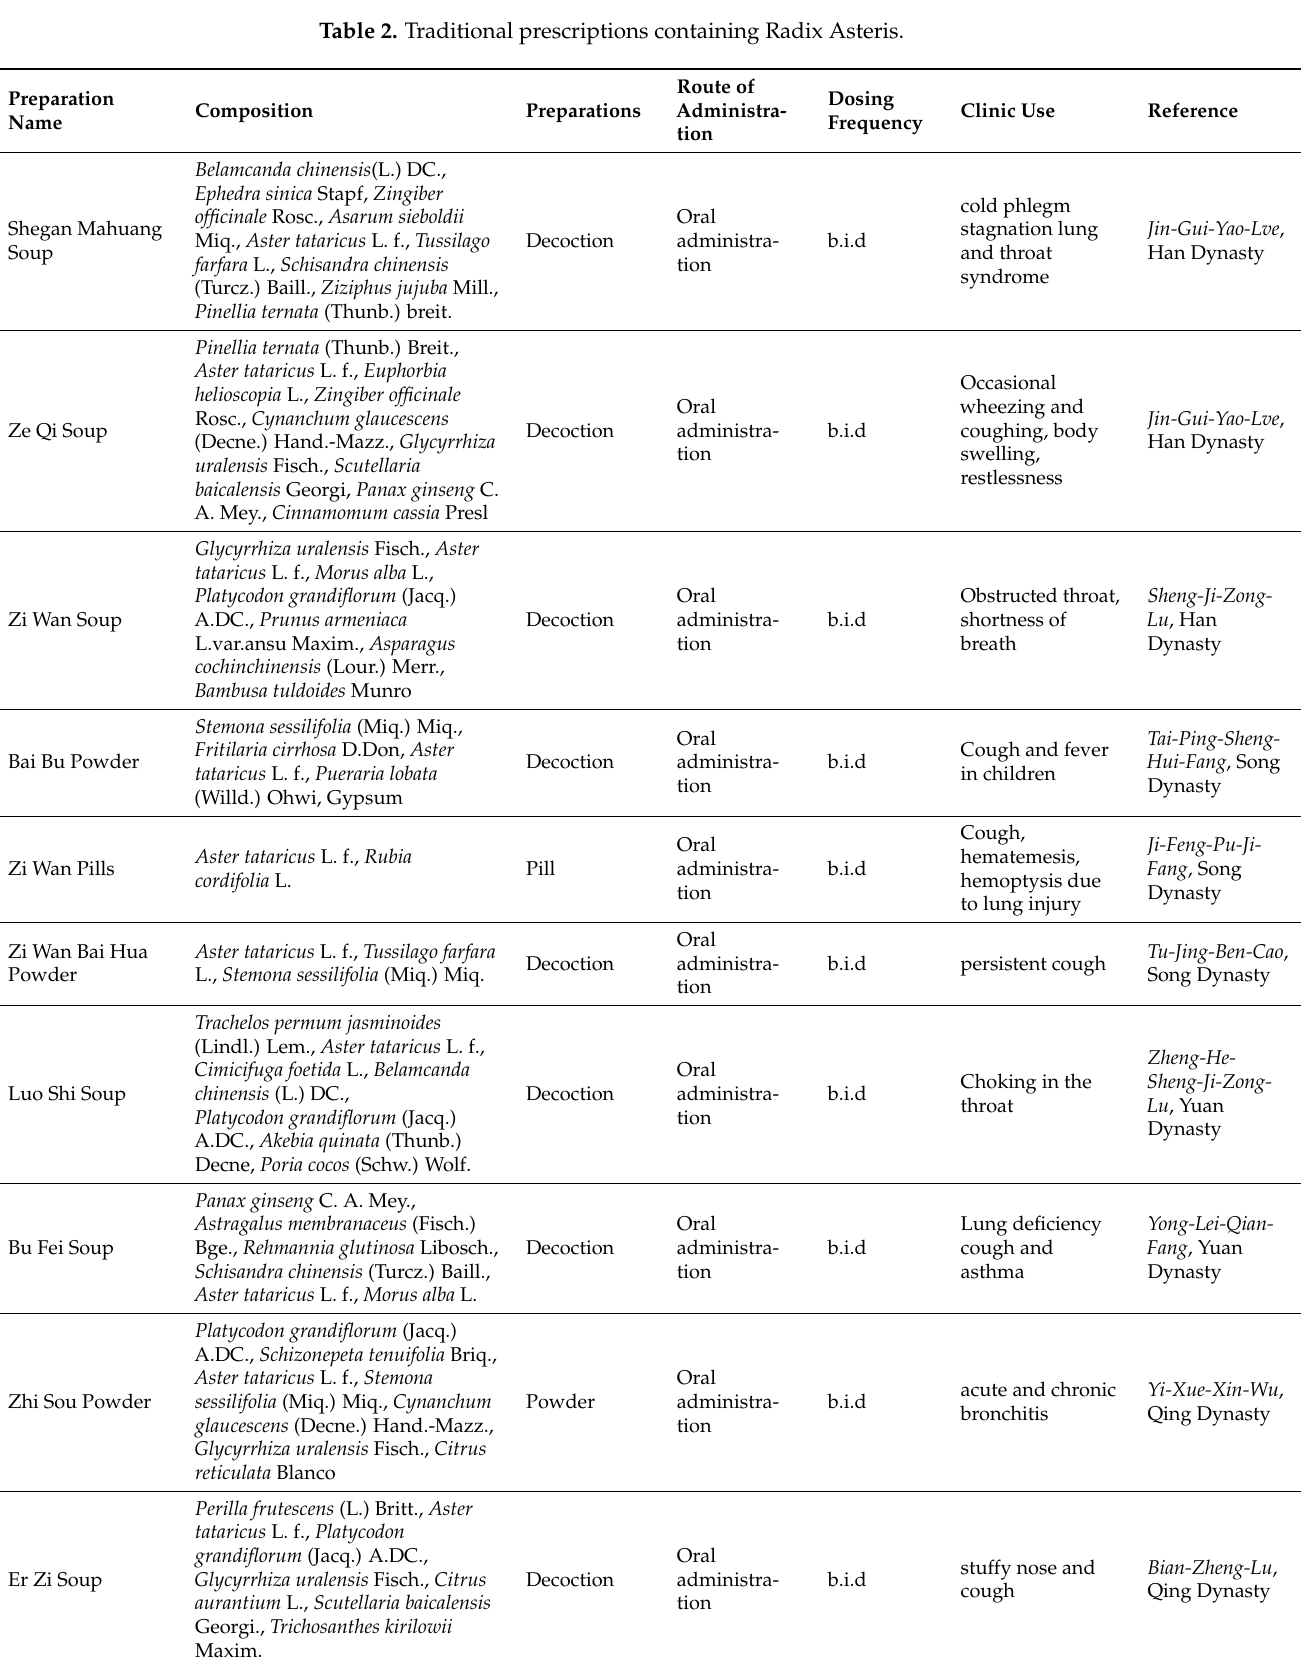
Table 2. Traditional prescriptions containing Radix